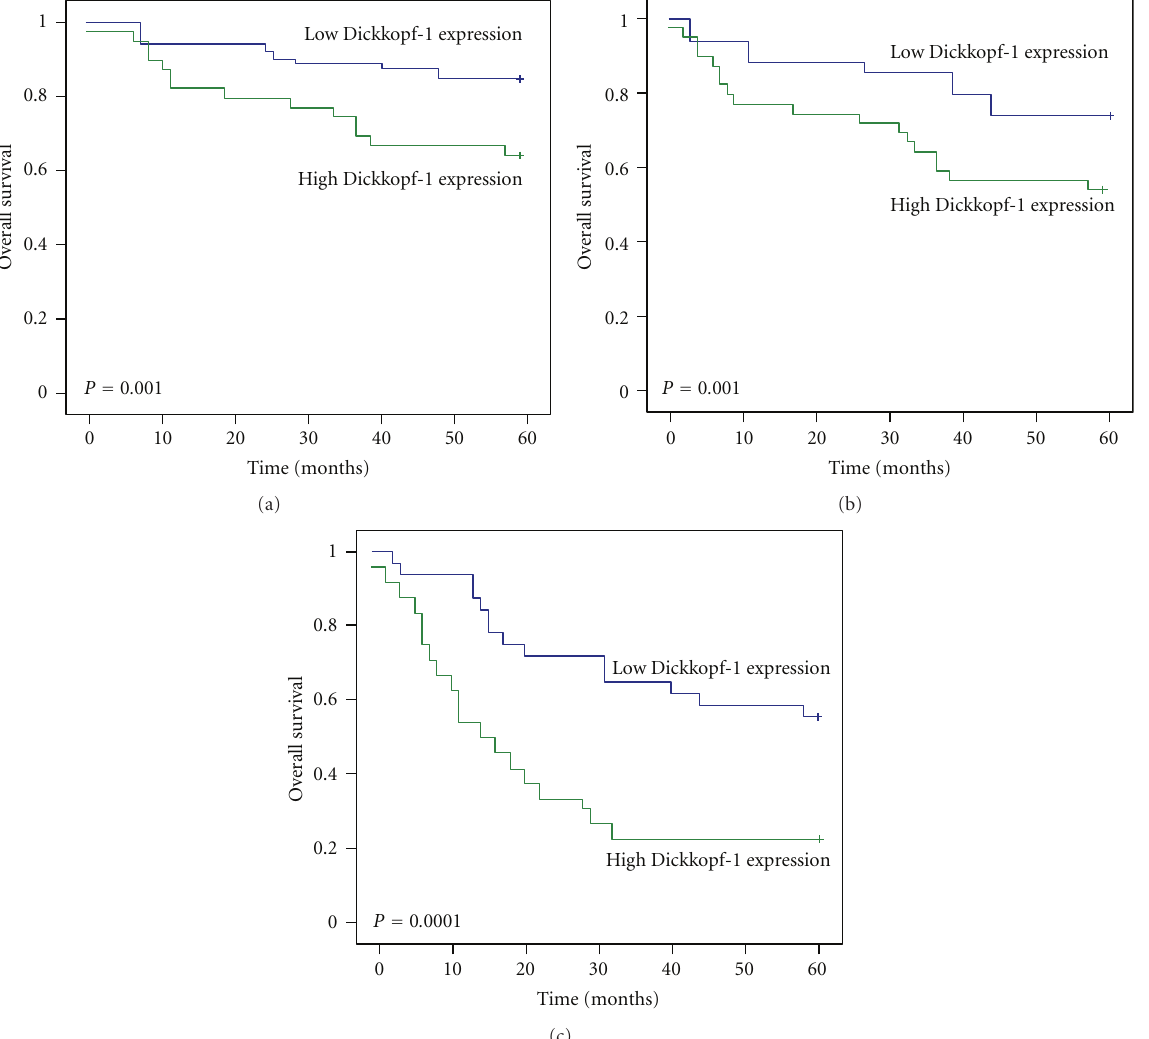
Figure 3: The Kaplan-Meier curves with univariate analyses (log-rank) for patients with low Dickkopf-1 expression versus high Dickkopf-1 expression tumors in all gastric cancers in stage I (a), II (b), and III (c). In stages I, II, and III gastric cancers, the 5-year survival rate of patients with a high expression of Dickkopf-1 was significantly lower than that in patients with low expression.